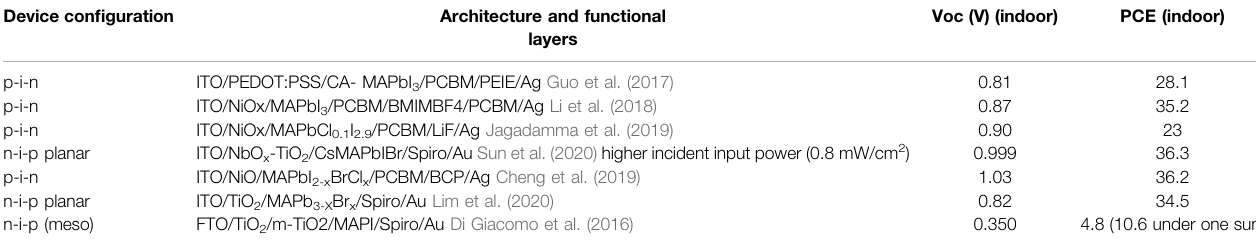
TABLE 2 | PCE and V oc of some typical halide perovskite-based indoor photovoltaics with different functional layers and device architecture. Device con fi guration Architecture and functional